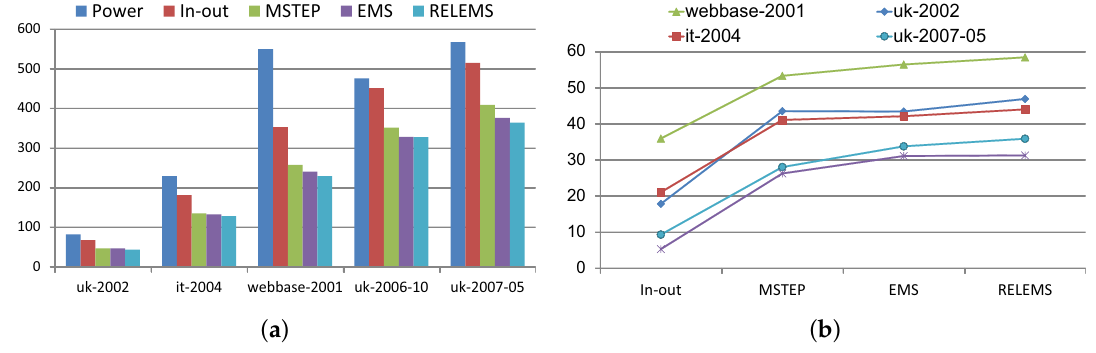
Figure 6. Non-stationary versus Power inner-outer algorithms, (cid:101) = 10 − 6 , DSM p = 32 ( 8 × 4 ) , α = 0.99, β = 0.99, q = 2, r = 30. ( a ) Total Time. ( b ) Time reduction with respect to the parallel Power algorithm ( % ) .